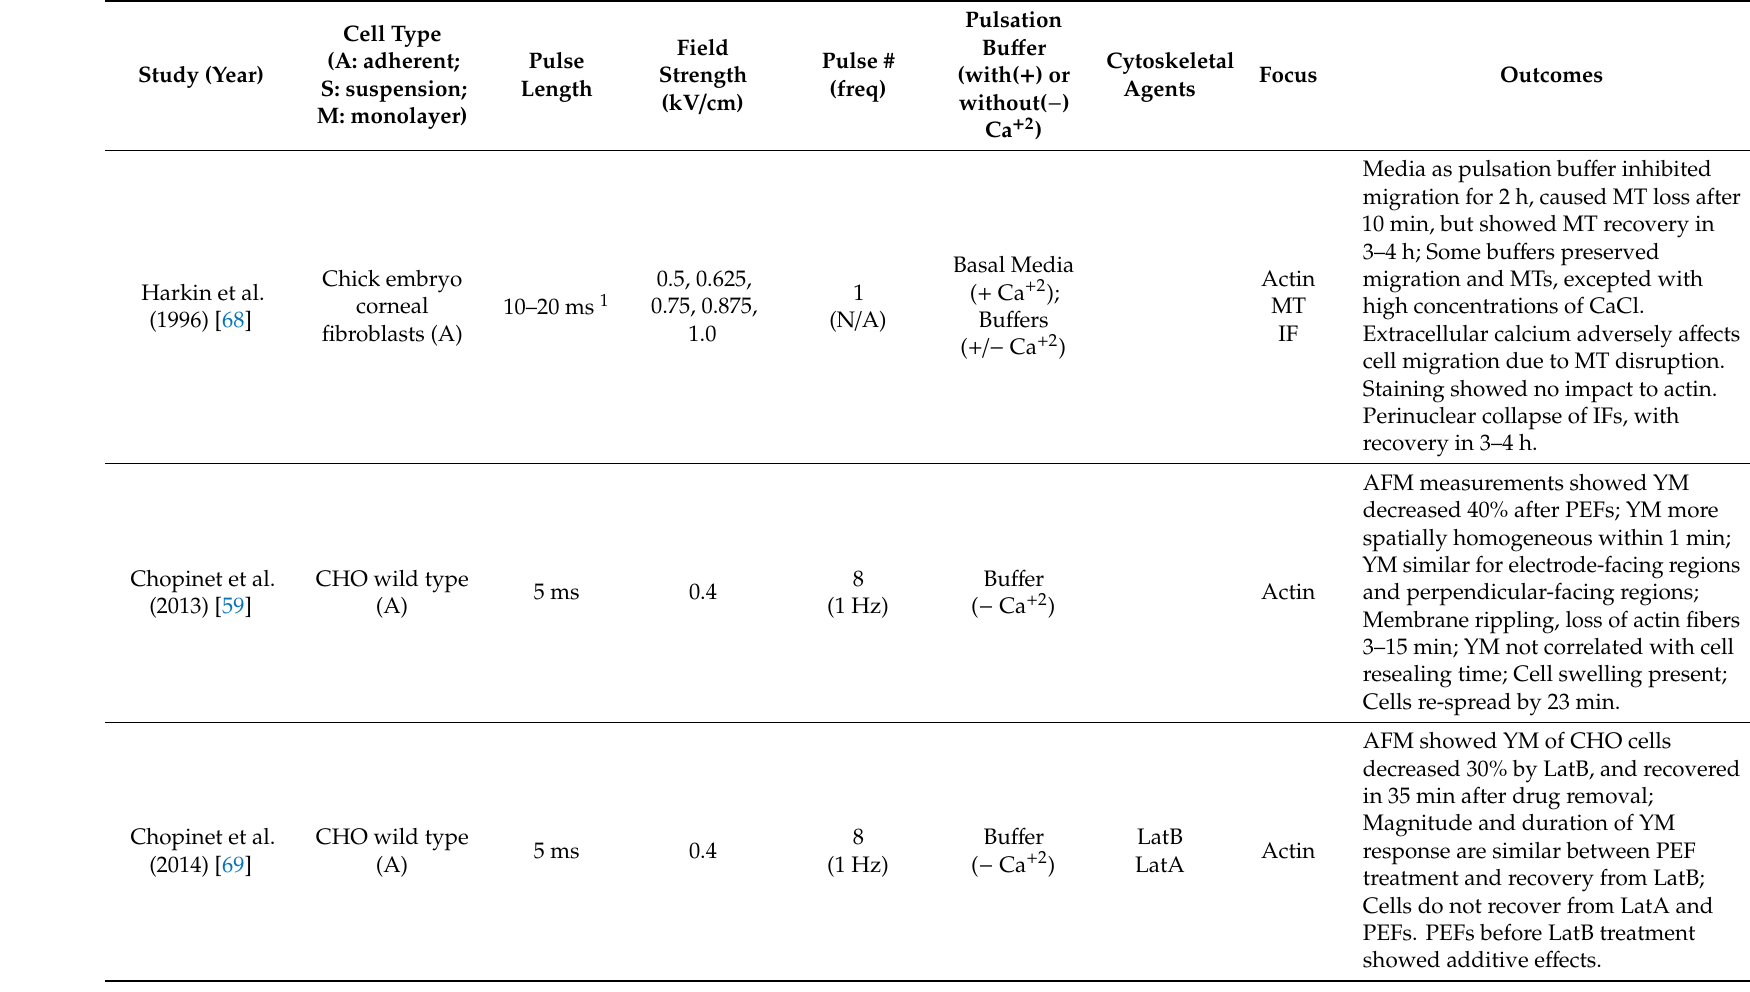
Table 1. Summary of studies on cytoskeletal disruption by pulsed electric